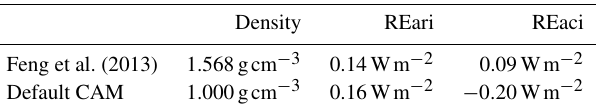
Table 5. Comparison of different model runs for the year 2003 with varying OA density. The values are BB and BF OA density from Feng et al. (2013), and the default CAM OA properties (Hess et al., 1998). REari and REaci are annual averages calculated for the BRC_CNST model